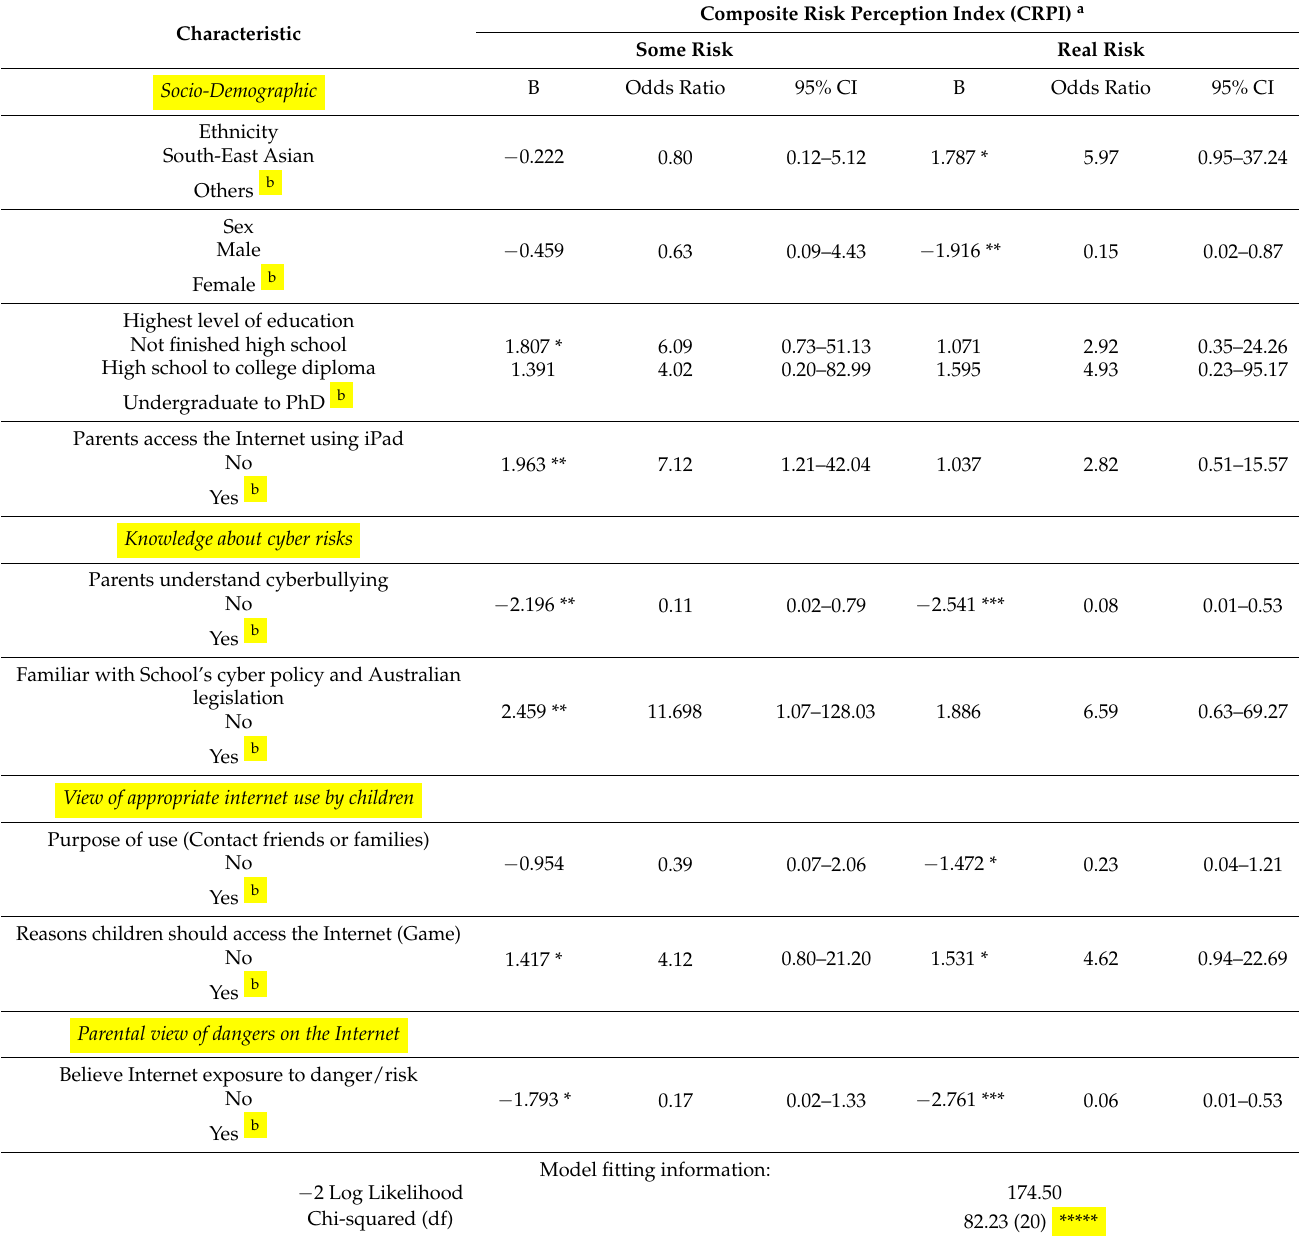
Table 3. Regression coefficients and odds ratios for the likelihood of moderate and severe forms of Composite Risk Perception of cyber risks faced by children by some selected significant